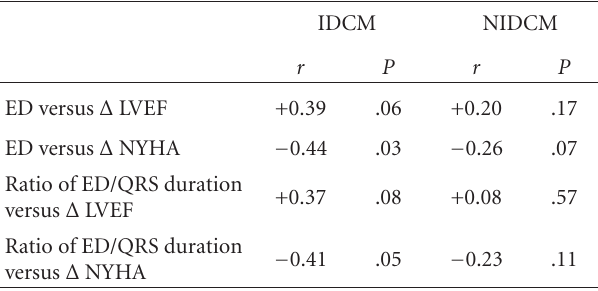
Table 4: Comparison of the value of ED in patients with ischemic and nonischemic